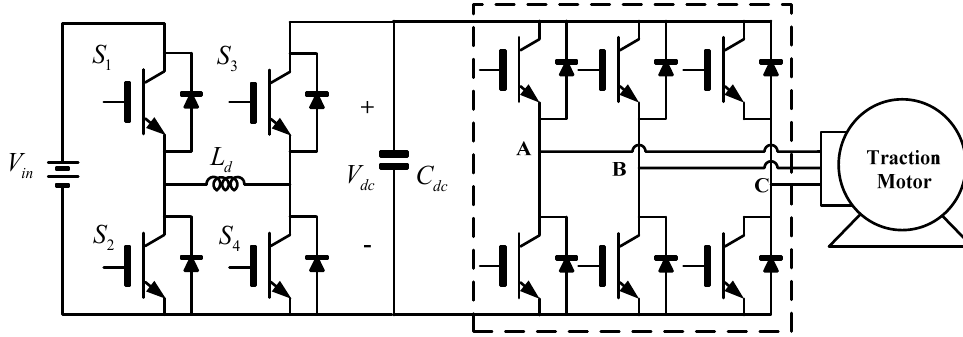
Figure 3. Bidirectional buck–boost converters for high–power EV applications [7].